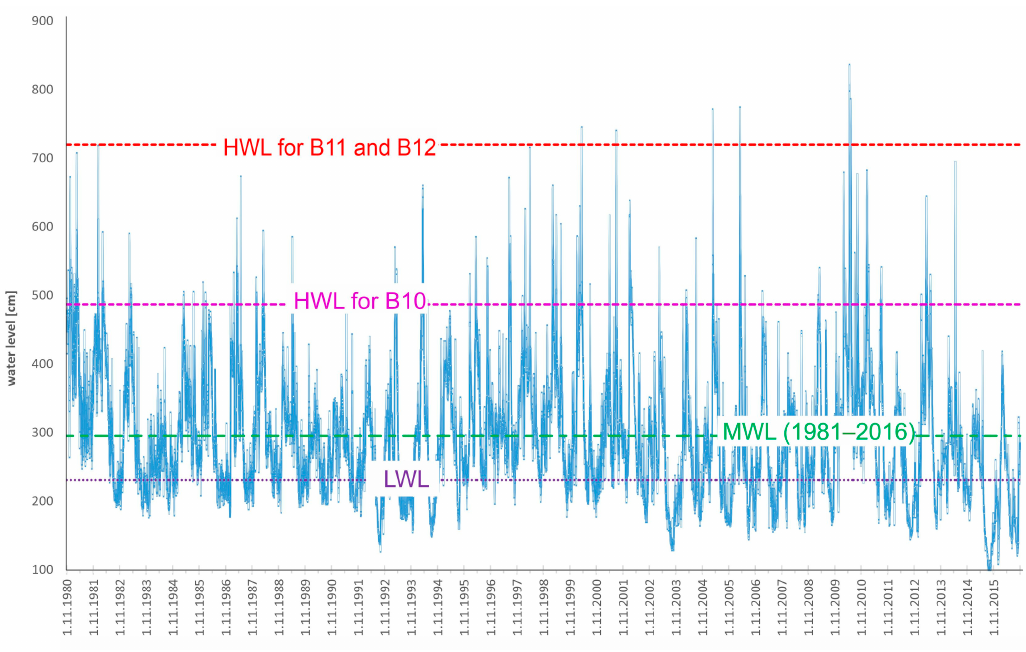
Table 7. Ice conditions on the lower part of the Vistula River (based on data from 1981–2016 col- lected by IMGW-PIB). Figure 7. Hydrograph of daily water level at Toru´n gauging station for the 1981–2016 period with Occurrence of the Event with the Probability (in %) delimitated values of HWL and LWL for bridges near Toru´n (B10–B12). Shaped on the basis of Figure 7. Hydrograph of daily water level at Toru ń gauging station for the 1981–2016 period with Type of Event delimitated values of HWL and LWL for bridges near Toru ń (B10–B12). Shaped on the basis of November IMGW-PIB in Warsaw IMGW-PIB in Warsaw data.